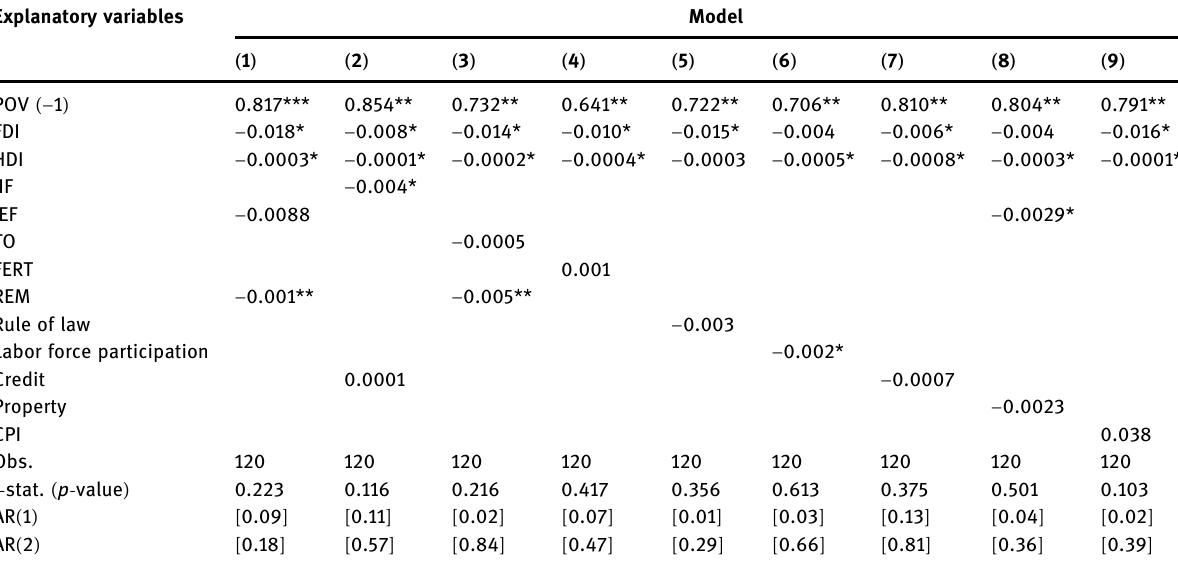
Table 6: GMM estimation results, where the dependent variable is Gini index Explanatory